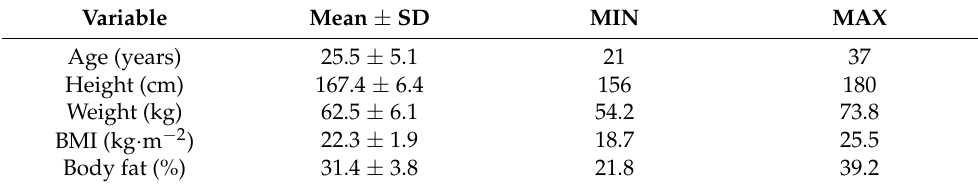
Table 2. Subject descriptive and anthropometric characteristics ( n = 32).